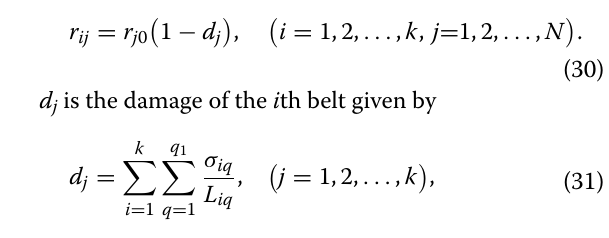
Figure 9 Reliability from proposed models and reliability from MCS